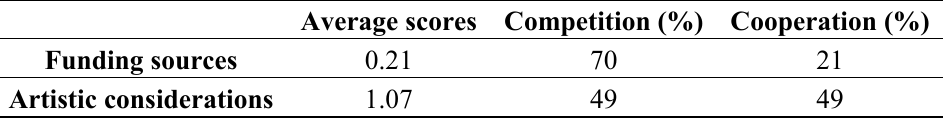
Table 4. Competition/Cooperation dimensions (total